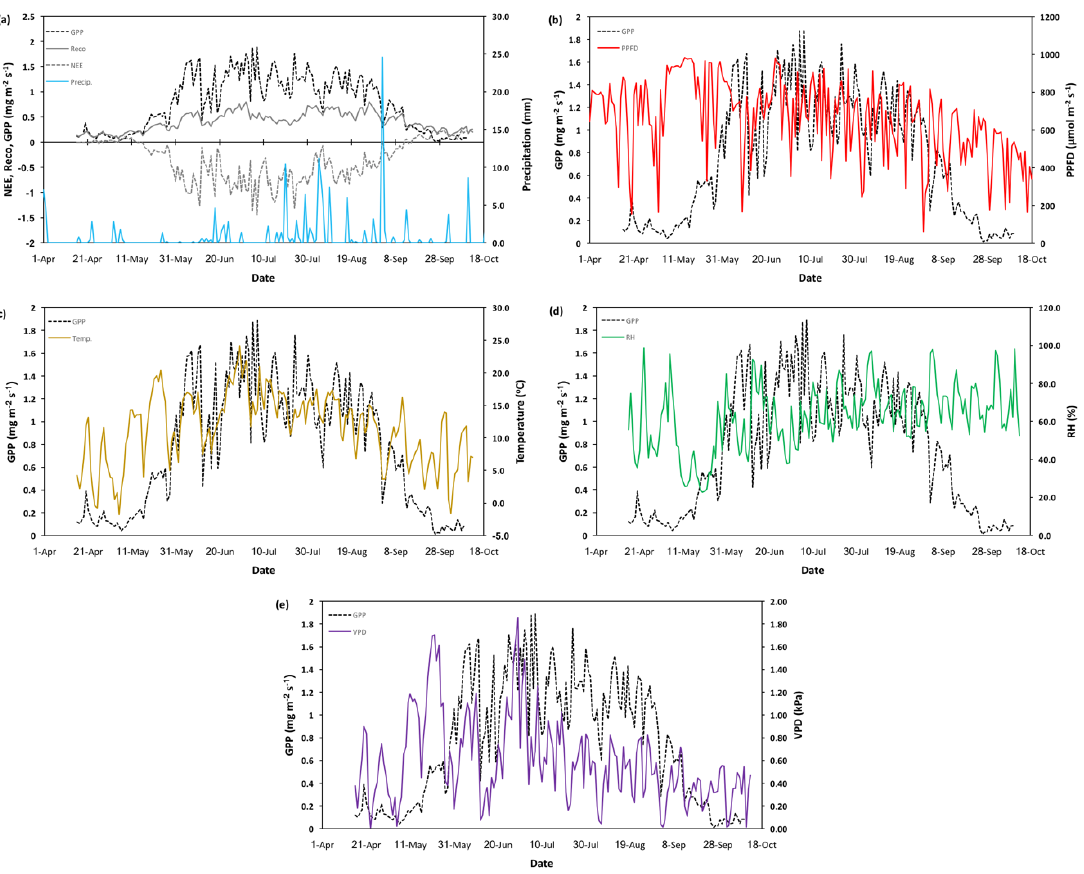
Figure A1. Gross primary productivity (GPP) and seasonal meteorological parameters for the 2015 growing season at the Peace River Environmental Monitoring Super Site. From top to bottom: ( a ) daily average net ecosystem exchange and ecosystem respiration, ( b ) photosynthetic photon flux density (PPFD), ( c ) temperature, ( d ) relative humidity (RH), and ( e ) vapor pressure deficit (VPD).